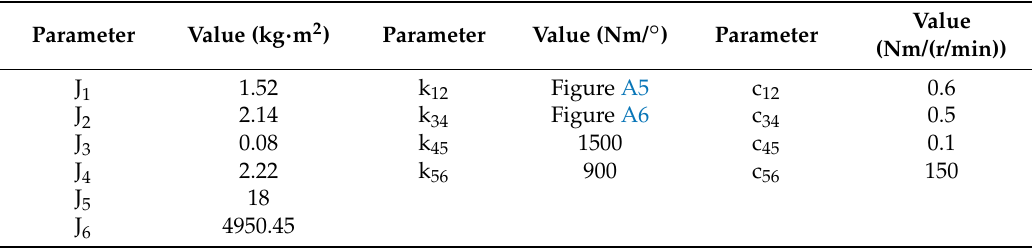
Figure A4. ISG controler in Simulink.